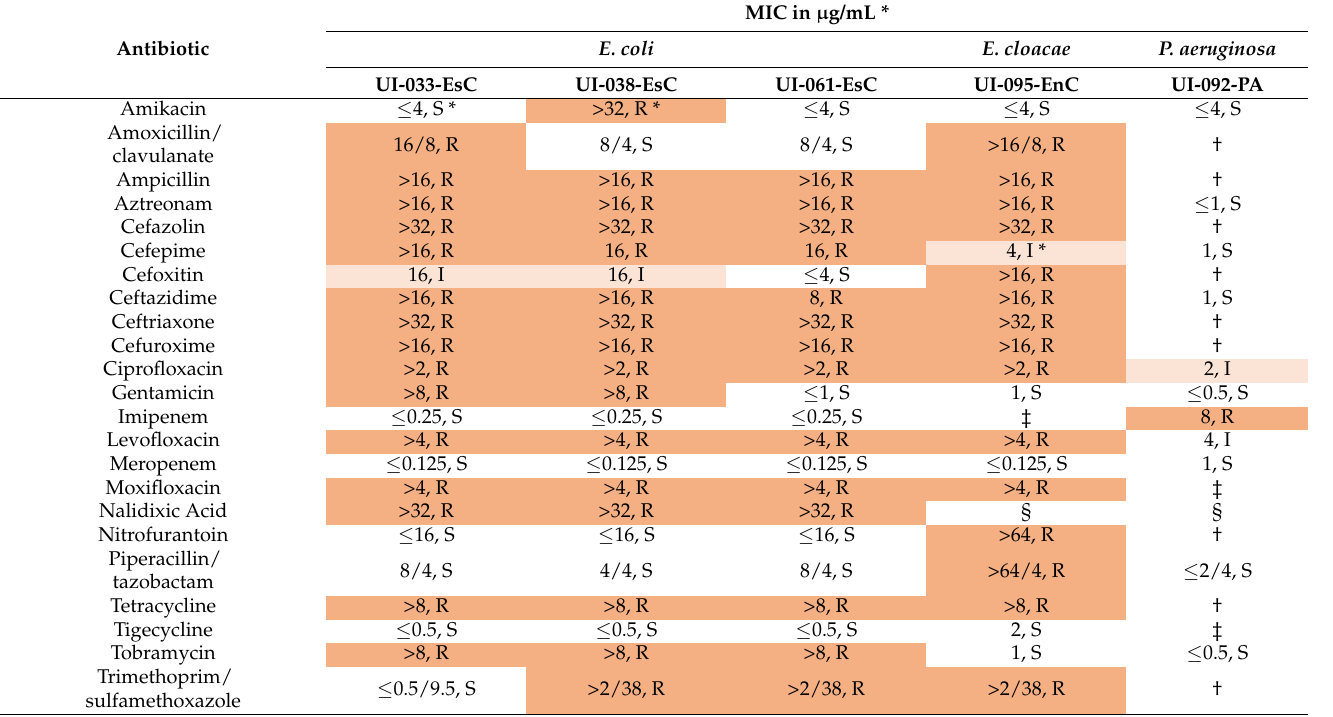
Table 1. Antibiotic susceptibility patterns of the five Gram-negative